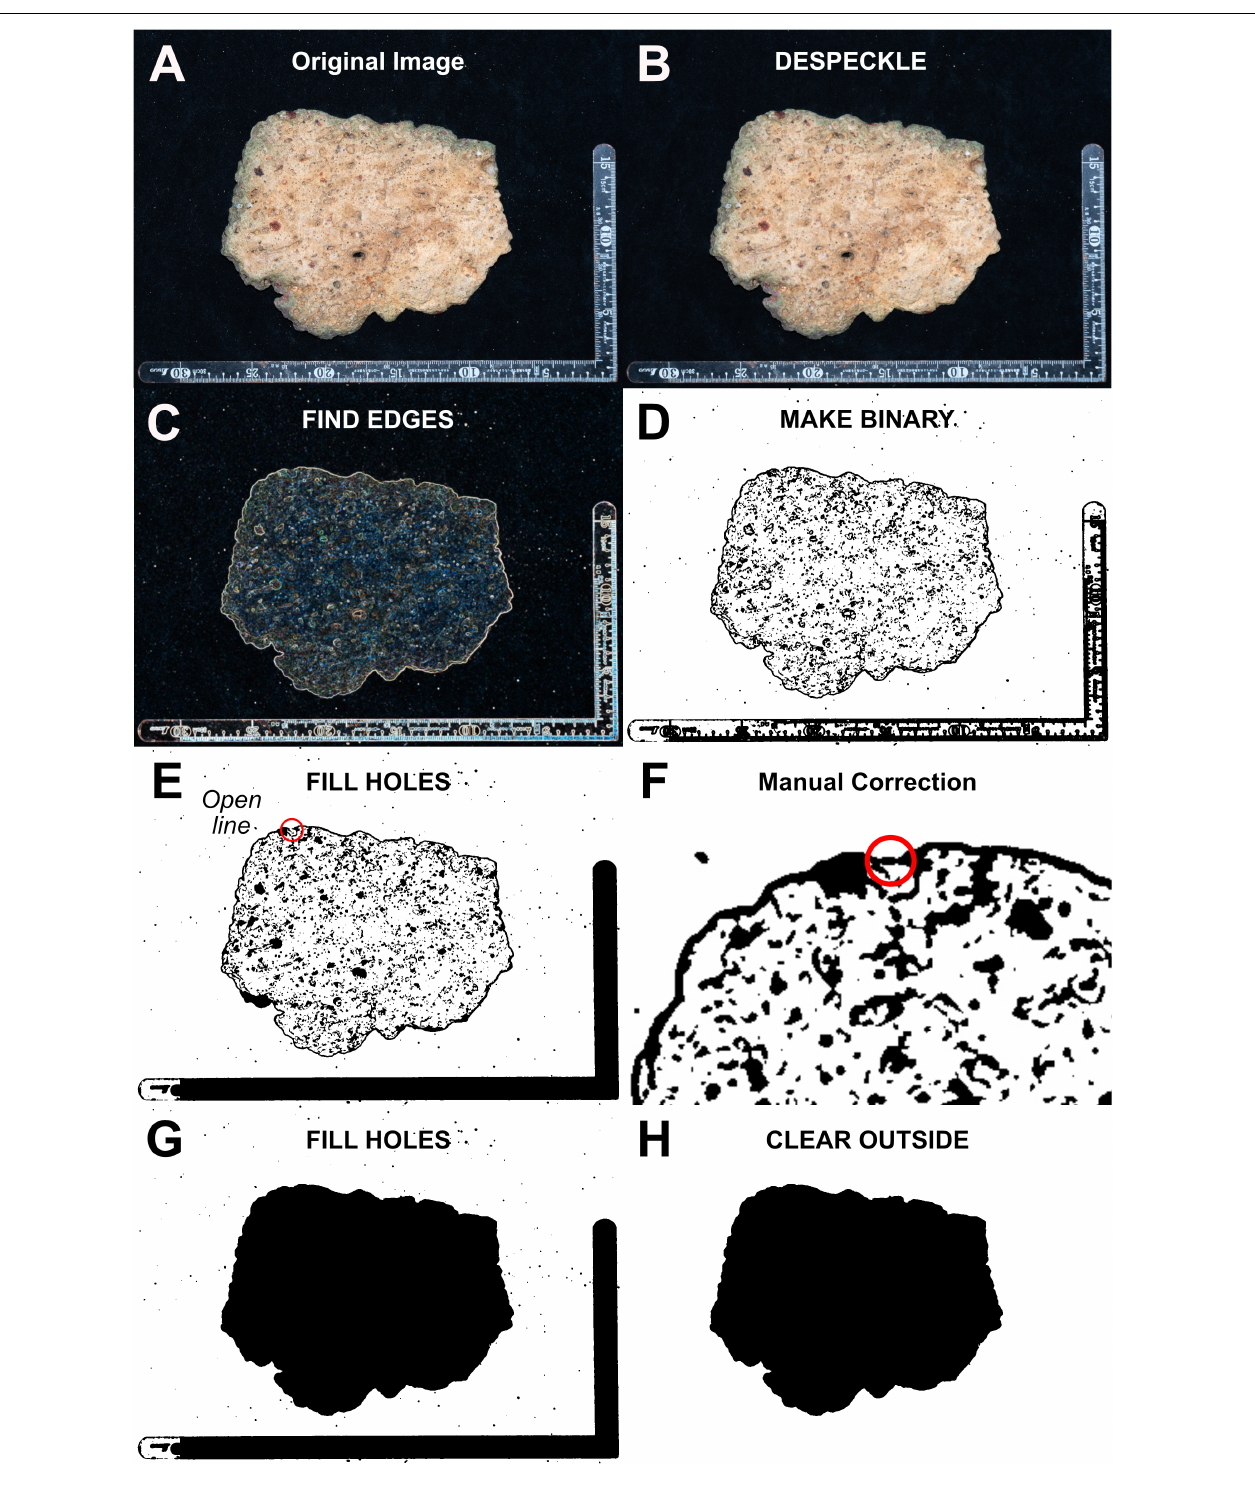
FIGURE 2 | Rubble segmentation workflow from the original image to the final outline. ImageJ function names are written fully capitalized. (A) Original image. (B) DESPECKLE. The presence of digital noise, filaments, and sand particles has been reduced. (C) FIND EDGES. The outline of the rubble piece has been highlighted. (D) MAKE BINARY. Pixels have been converted to black or white values. (E) FILL HOLES. In this example, the outline was not closing perfectly (a red circle is added to this figure to highlight the problematic area). (F) Manual correction. The open spot within the red circle has now been manually fixed (traced). (G) FILL HOLES. The function confirmed that the outline was properly closed. (H) Final outline. If not needed, background elements can optionally be removed using the CLEAR OUTSIDE function.